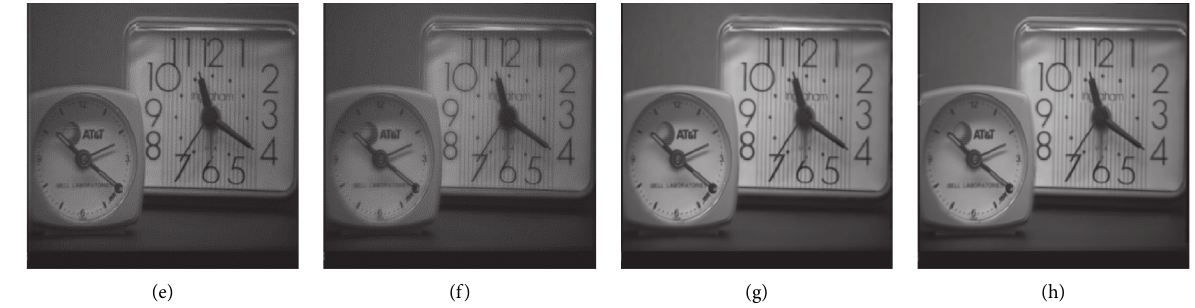
Figure 8: The fusion results of “Clocks.” (a) PCNN. (b) Contourlet. (c) GAN. (d) Shearlet. (e) CSR. (f) SR-SML. (g) DCNN. (h) Proposed.